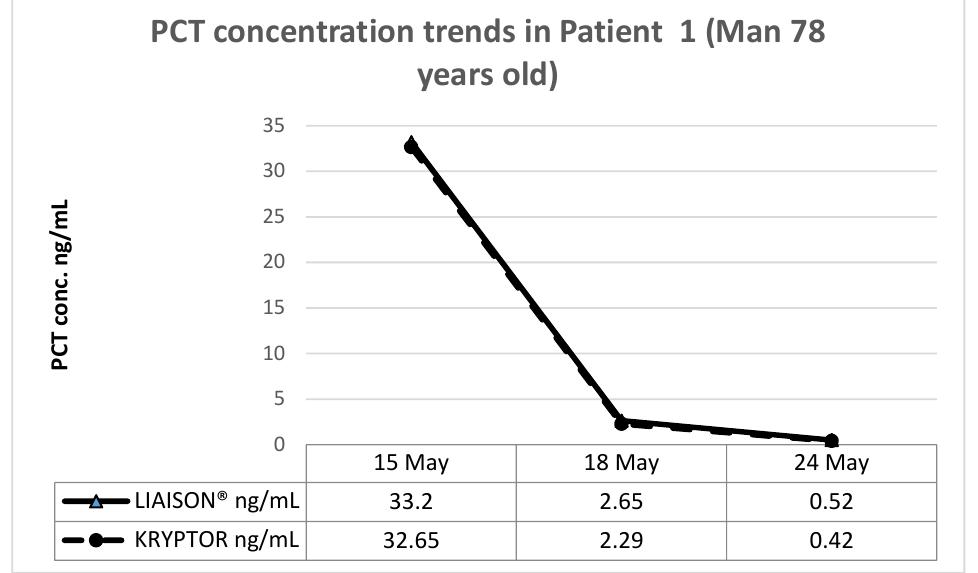
Figure 3. Patient 1 (Internal medicine, man 78 years old).